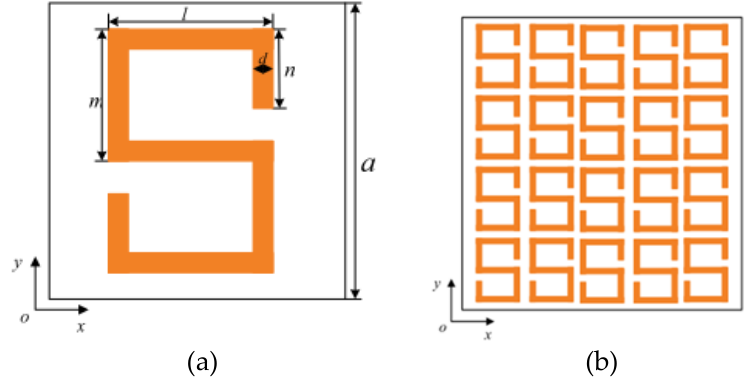
Figure 14. Schematic diagram of proposed structures: ( a ) The unit cell of an S-shape slot phononic crystal (PC); ( b ) Schematic view of the cross-section of the two-dimensional PC [54].